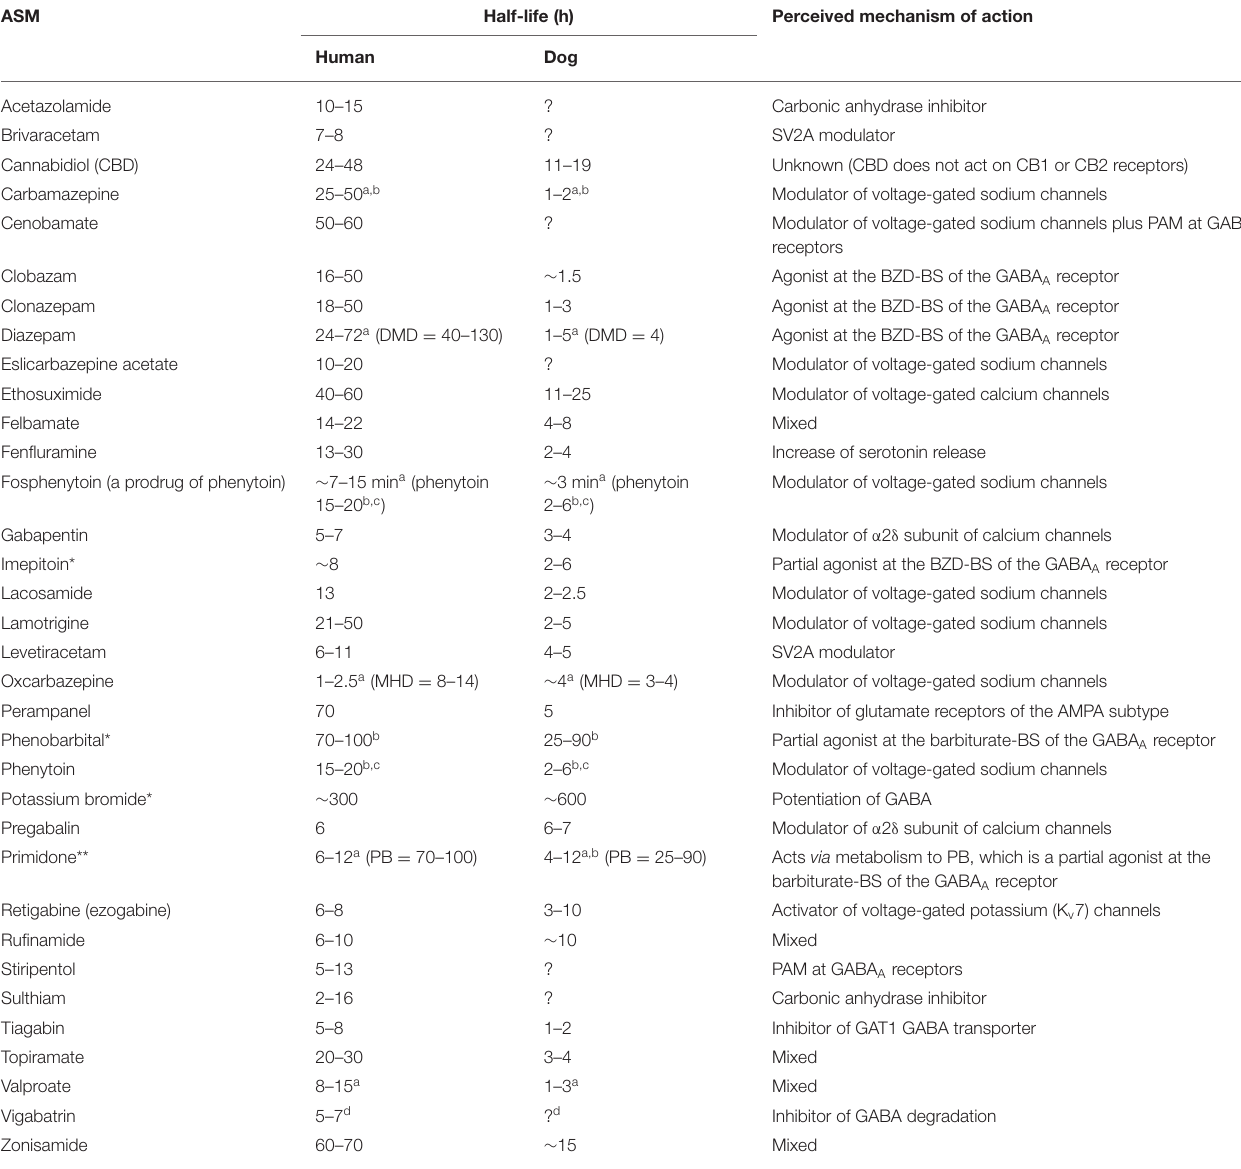
TABLE 1 | A comparison of elimination half-lives of antiseizure medications (ASMs) in humans and dogs.